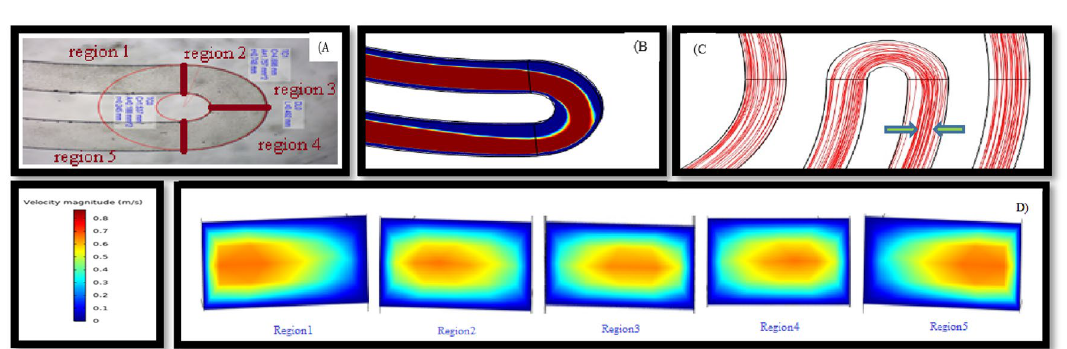
Figure 6. maximum velocity displacement due to high ratio turn. ( A ) Showed the turn of the microchannel which is made by soft lithography under the microscope. ( B ) Illustrated the velocity field as well as maximum velocity displacement along the microchannel. ( C ) This plot shows the streamlines of the flow field inside the microchannel, it is clear that the compression of these streamlines increases after the U-turn, and ( D ( indicated that maximum velocity had been shifted from outer wall into inner